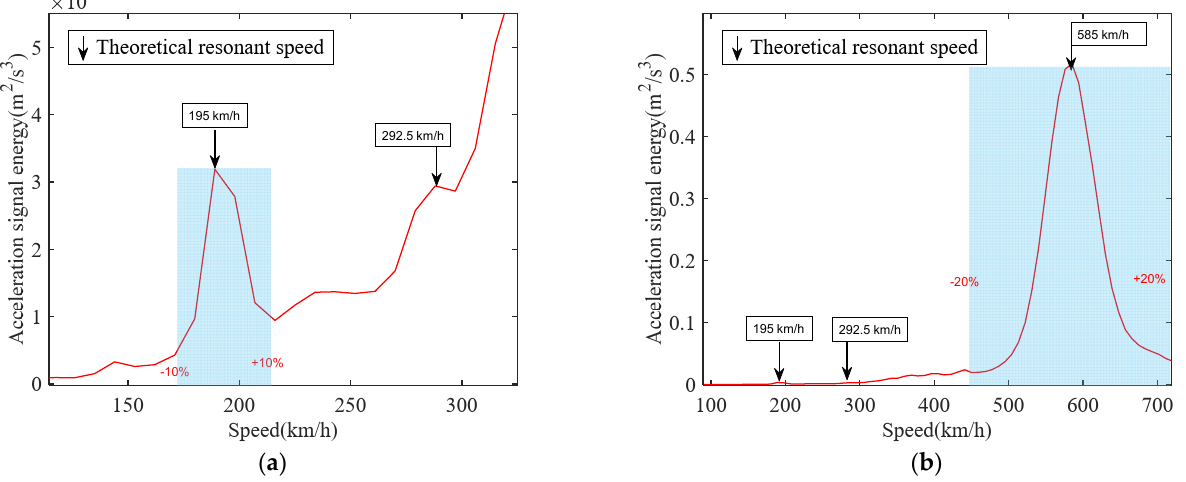
Figure 6. Mid–span bridge vertical vibratory acceleration signal energy in the function of train speed: ( a ) Local view; ( b ) Global view.